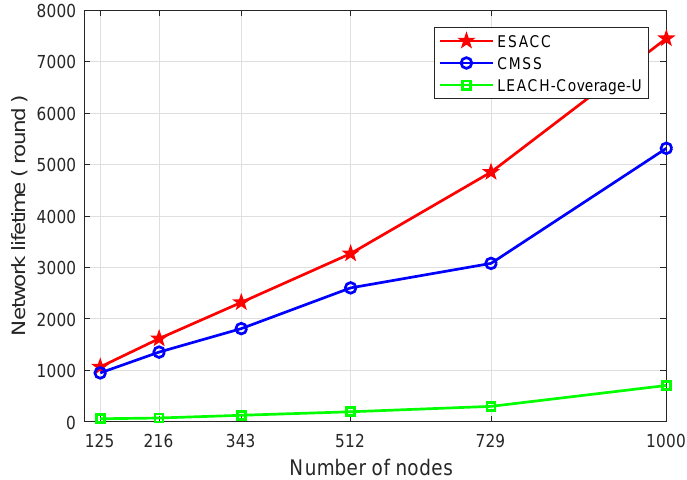
Figure 8. Relationship between network lifetime and number of